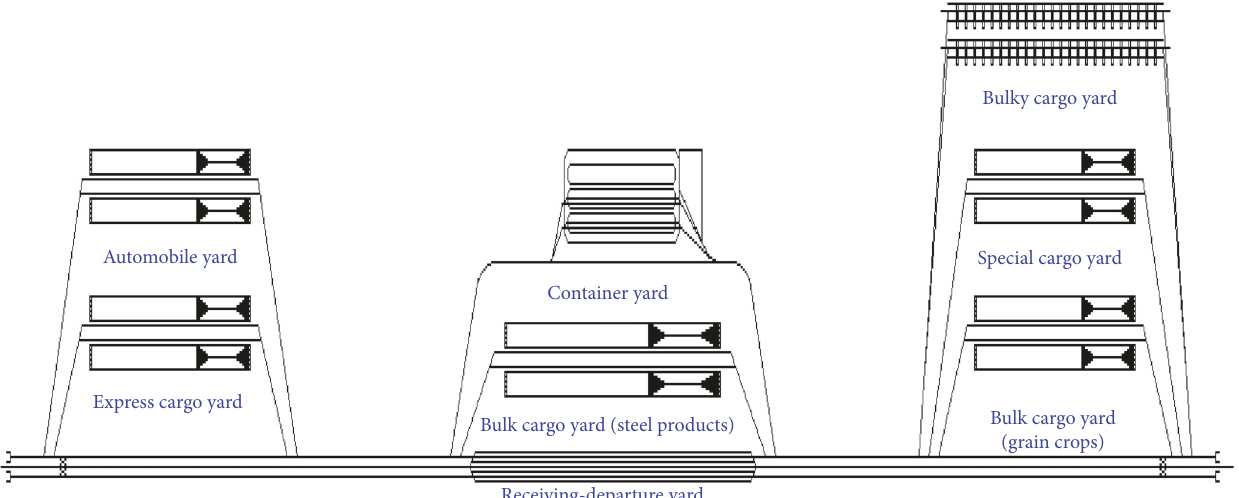
Figure 16: Yards layout of Qianchang railway intermodal terminal.